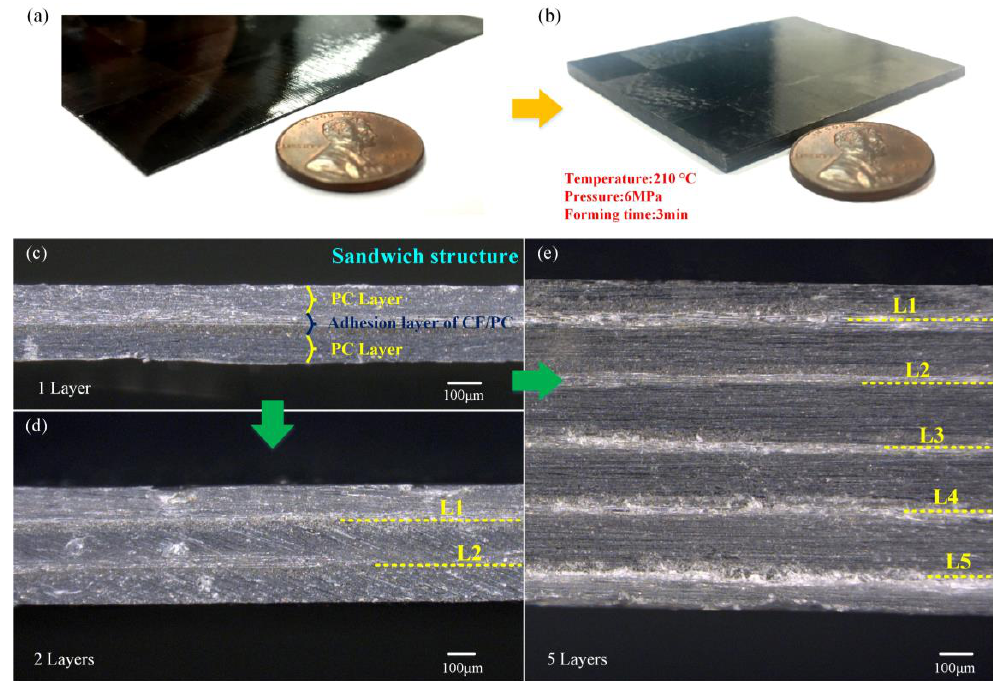
Figure 4. The morphologies of a unit-CFPL and several multi-CFPLs prepared by optimal laminating parameters: ( a , b ) show the visual images of 1-layer and 10-layer multi-CFPLs from the axonometric view, respectively; ( c – e ) shows the cross sections of 1-layer, 2-layer and 5-layer multi-CFPLs,